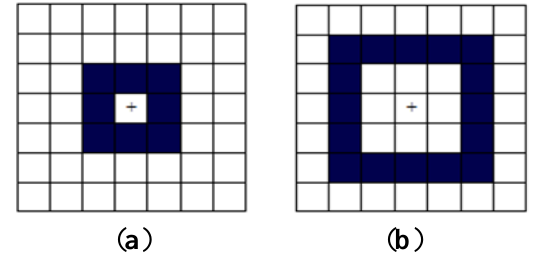
Figure 3. The square symmetric neighborhoods with different R for extracting WLD features. ( a ) The neighborhood with R = 1. ( b ) The neighborhood with R =